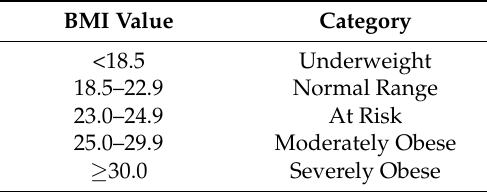
Table 1. BMI categories for